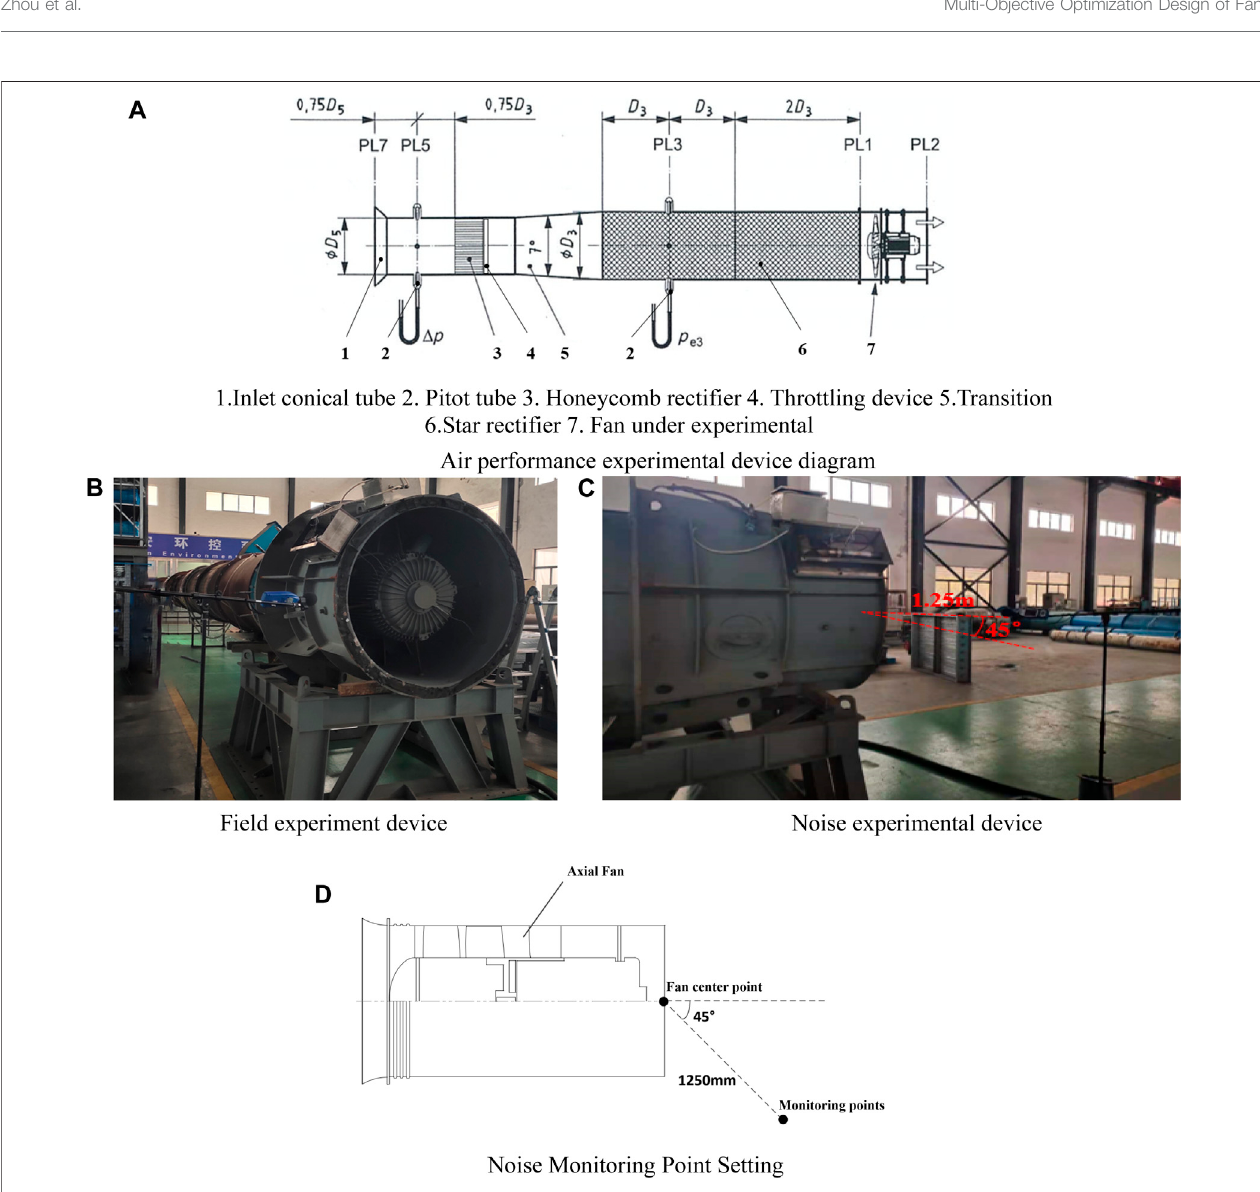
FIGURE 4 | Experimental devices. 1. Inlet conical tube 2. Pitot tube 3. Honeycomb recti fi er 4. Throttling device 5. Transition 6. Star recti fi er 7. Fan under experimental (A) Air performance experimental device diagram (B) Field experiment device (C) Noise experimental device (D) Noise Monitoring Point Setting.